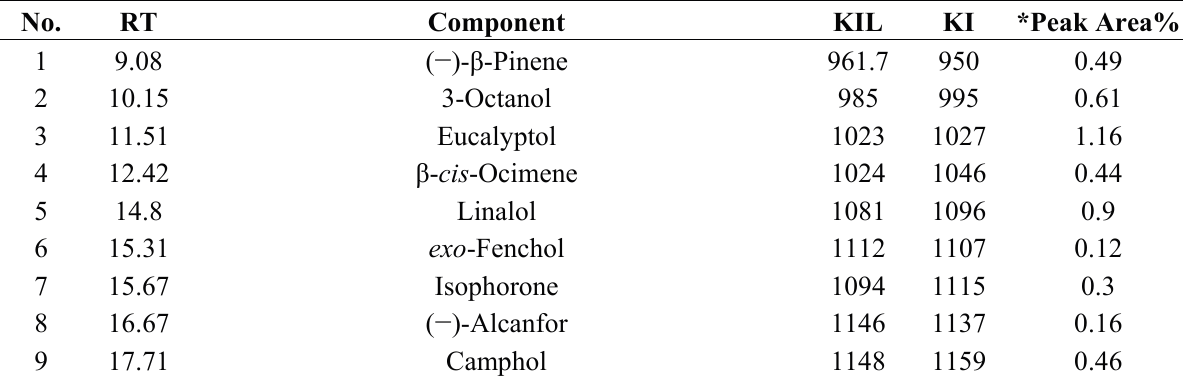
Figure 1. Structures of β -caryophyllene ( a ) and caryophyllene oxide ( b ). Table 1. S. ballotiflora Essential Oil Chemical